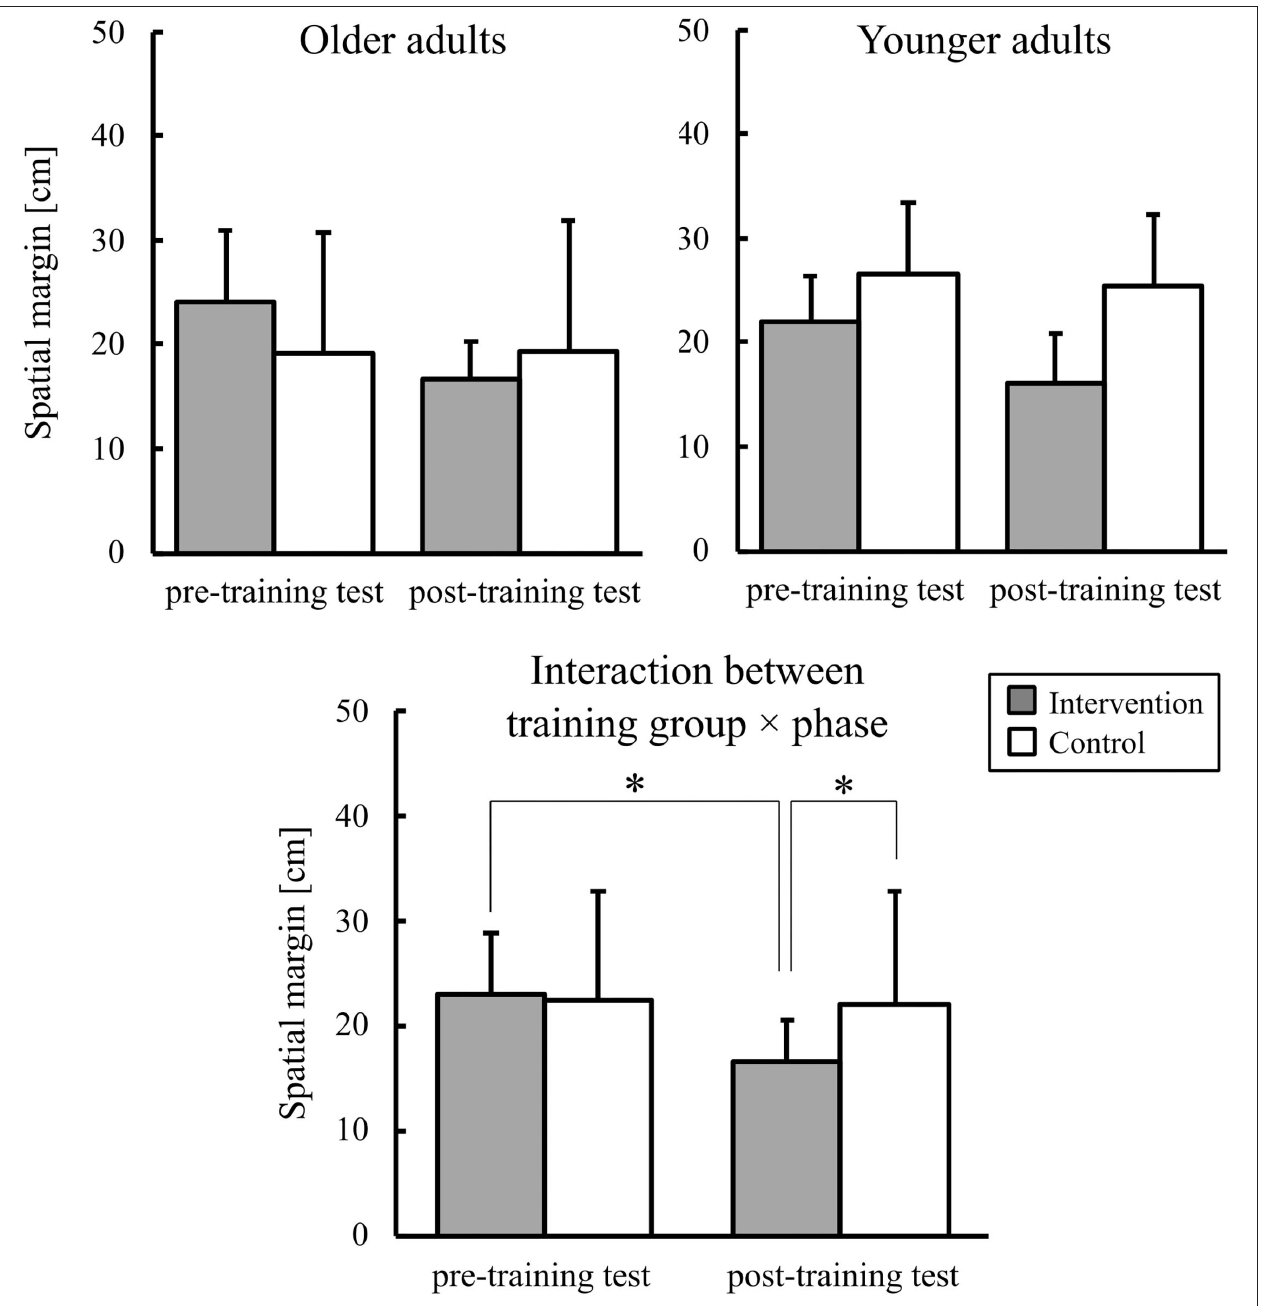
FIGURE 6 | Graphs of the mean spatial margin. Error bars represent the standard deviation among participants. * indicates the significant difference.